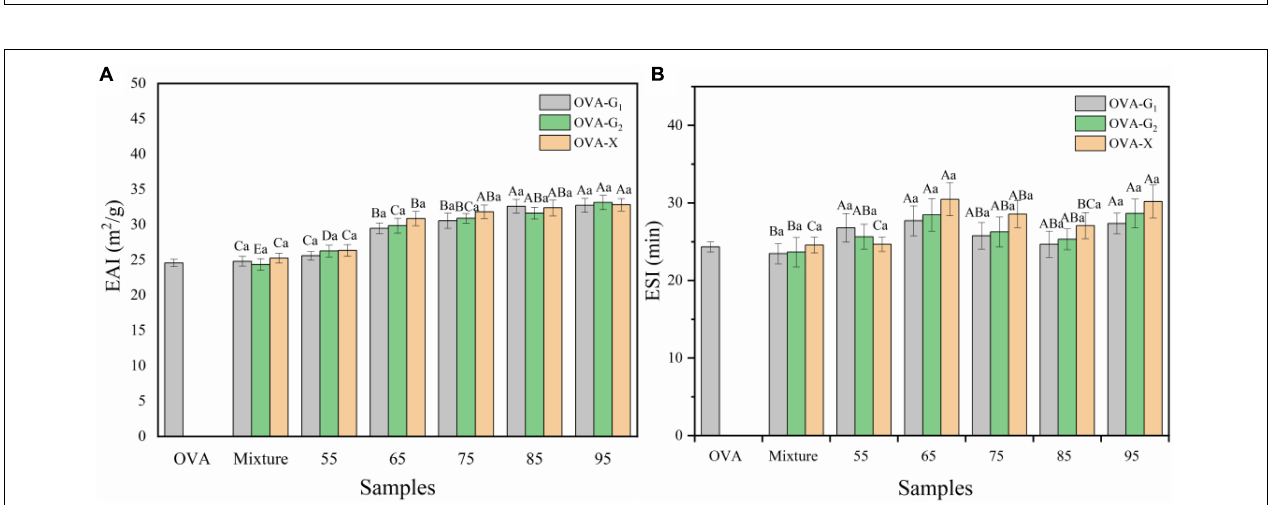
FIGURE 5 | Emulsifying activity index (A) and emulsion stability index (B) of OVA-G 1 , OVA-G 2 , and OVA-X at different reaction temperatures. Different lowercase letters indicate significant differences ( P < 0.05) between OVA-monosaccharide conjugates of different sugar types. Different capital letters indicate significant differences ( P < 0.05) in OVA, Mixture, and OVA-monosaccharide conjugates formed at different reaction temperatures.